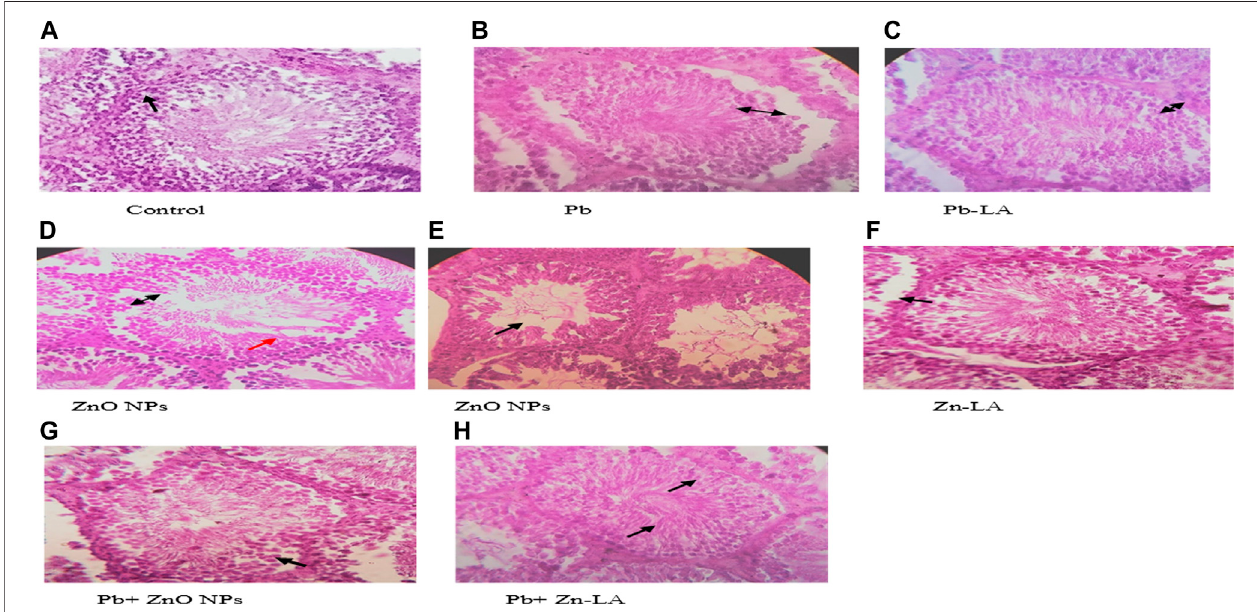
FIGURE16| Photographsofthetestesofexperimentalanimals. (A) Controlgroupshowingnormalseminiferoustubules(Sts)linedbystrati fi edgerminalepithelium (aspresentedbyblackarrow). (B) Lead-treated groupshowingseparatedgerminalepitheliumfromtheirbasementmembrane(blackarrow). (C) lipoicacid – treatedlead group showing a regular basal lamina (black arrow). (D) Zinc oxide nanoparticle group showing degeneration of germinal epithelium (black arrow) and vacuolations (red arrow). (E) Zincoxidenanoparticlegroupshowingthelargediameteroflumen(blackarrow). (F) Lipoicacid – treatedzincoxidenanoparticlegroupshowingaregular basal lamina and germinal epithelium layer (black arrow). (G) Lead and zinc oxide nanoparticle groups showing irregular basal lamina (black arrow). (H) Lipoic acid – treated lead and zinc oxide nanoparticle groups showing a regular basal lamina, germinal epithelium layer, and sperms in the lumen (black